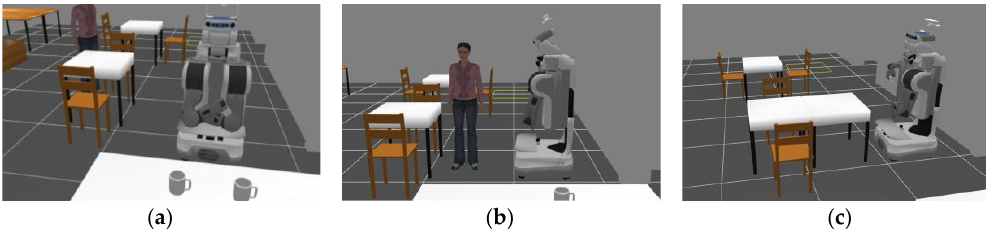
Figure 3. ( a ) Sub-scenario 1: learn how to serve coffee without any obstacle; ( b ) sub-scenario 2: learn how to deal with the obstacle, which is a person in this example; ( c ) sub-scenario 3: learn how to deal with the obstacle, which is an extension table in this example.